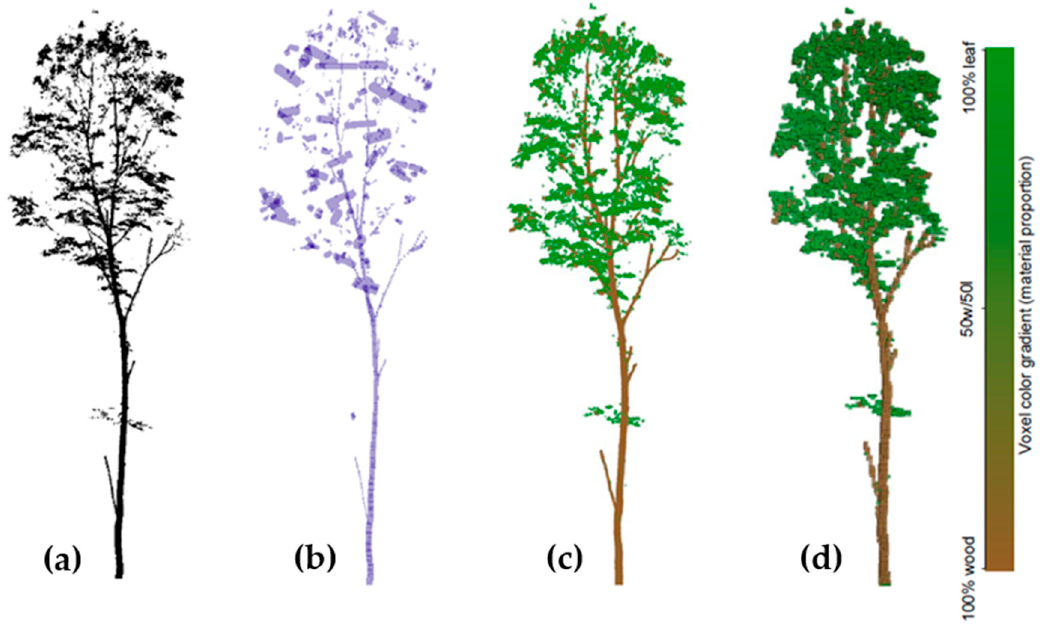
Figure 1. Illustration of the steps for wood/leaves separation. ( a ) Sugar maple point cloud. ( b ) Illustration of the cylinder fitting on point cloud (before filtering). ( c ) Point cloud discriminated with wood and leaves points separated (after cylinders filtering). Assignment points clusters to wood depends on cylinders fitting using a threshold fitting error. Leaf points correspond to points not assigned to wood. ( d ) Voxel grid representing the proportion of wood and leaves points.